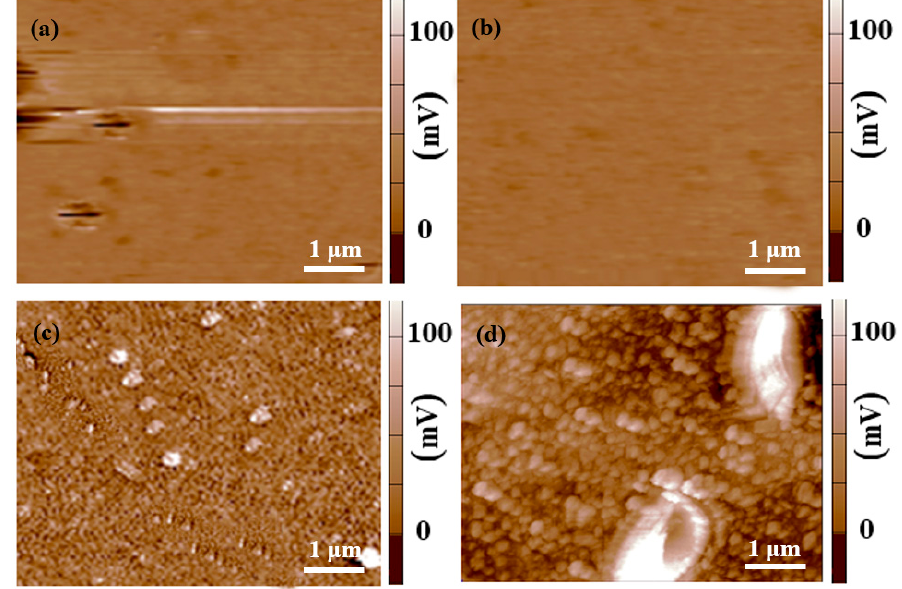
Figure 13. Surface Volta potential distribution of MZM-xCa. ( a ) 0%; ( b ) 0.38%; ( c ) 0.76%; and ( d ) 1.10%.